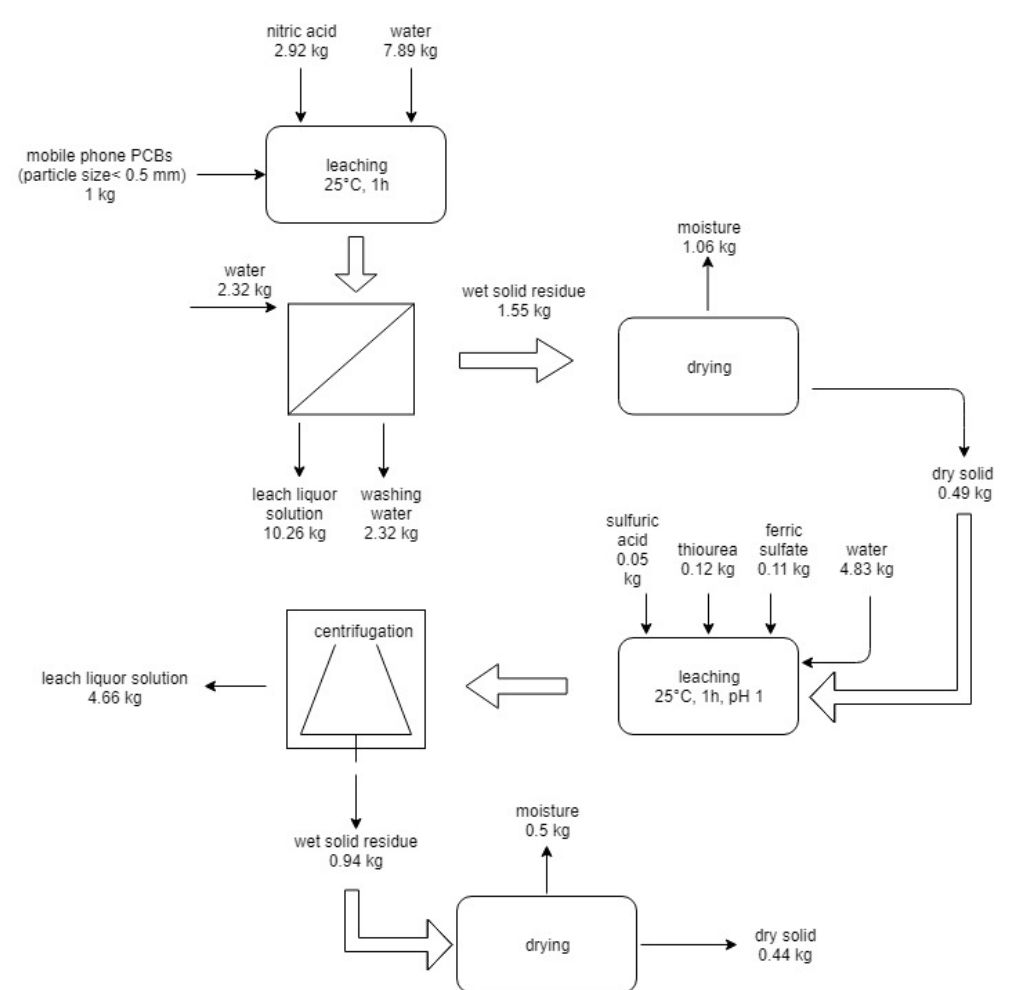
Figure 6. Flowsheet and mass balance of the second route process for the treatment of 1 kg of end-of-life mobile PCBs.